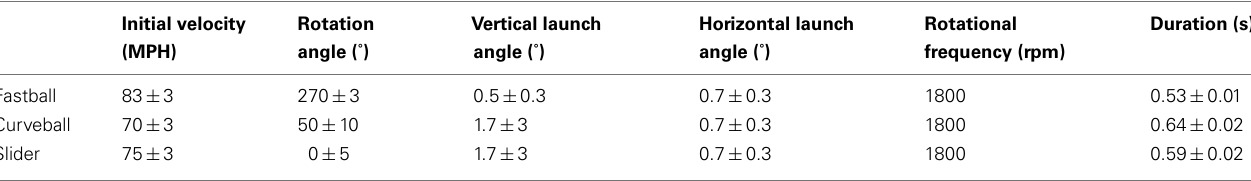
Table 1 | Parameters for generating pitch trajectories.